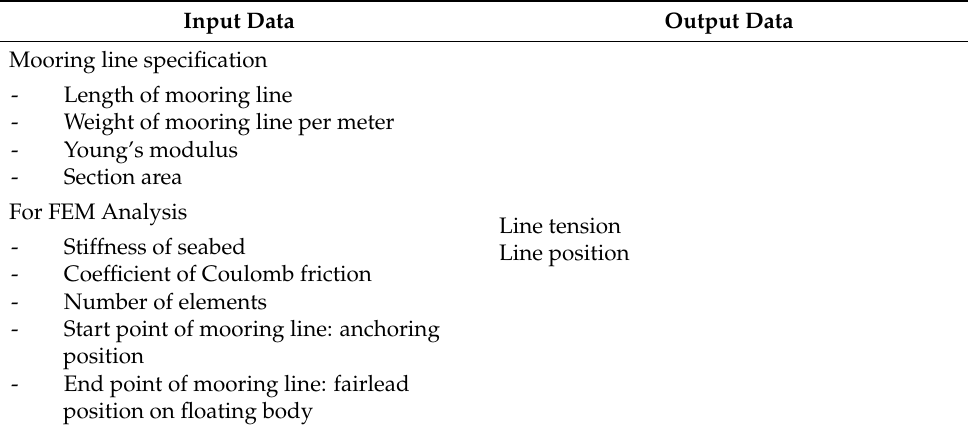
Figure 1. Simulation program for dynamic analysis of offshore operation [1]. The input and output data for the static analysis are listed in Table 1. Table 1. Input and output data for mooring analysis.